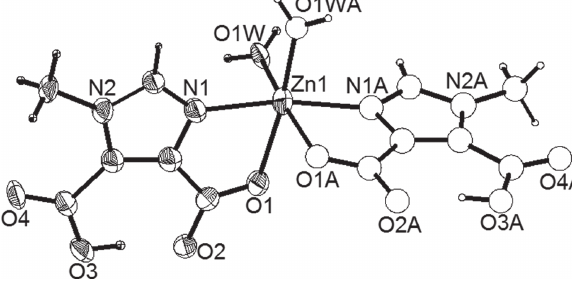
Table 1: Data collection and handling.